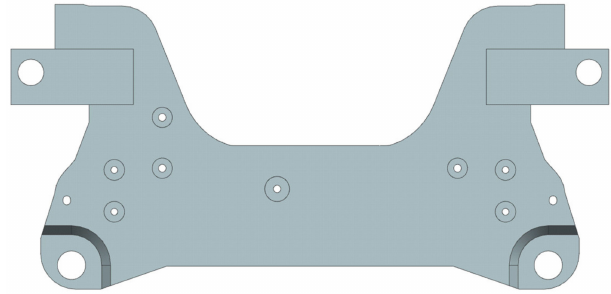
Figure 1. Aluminium alloy front subframe